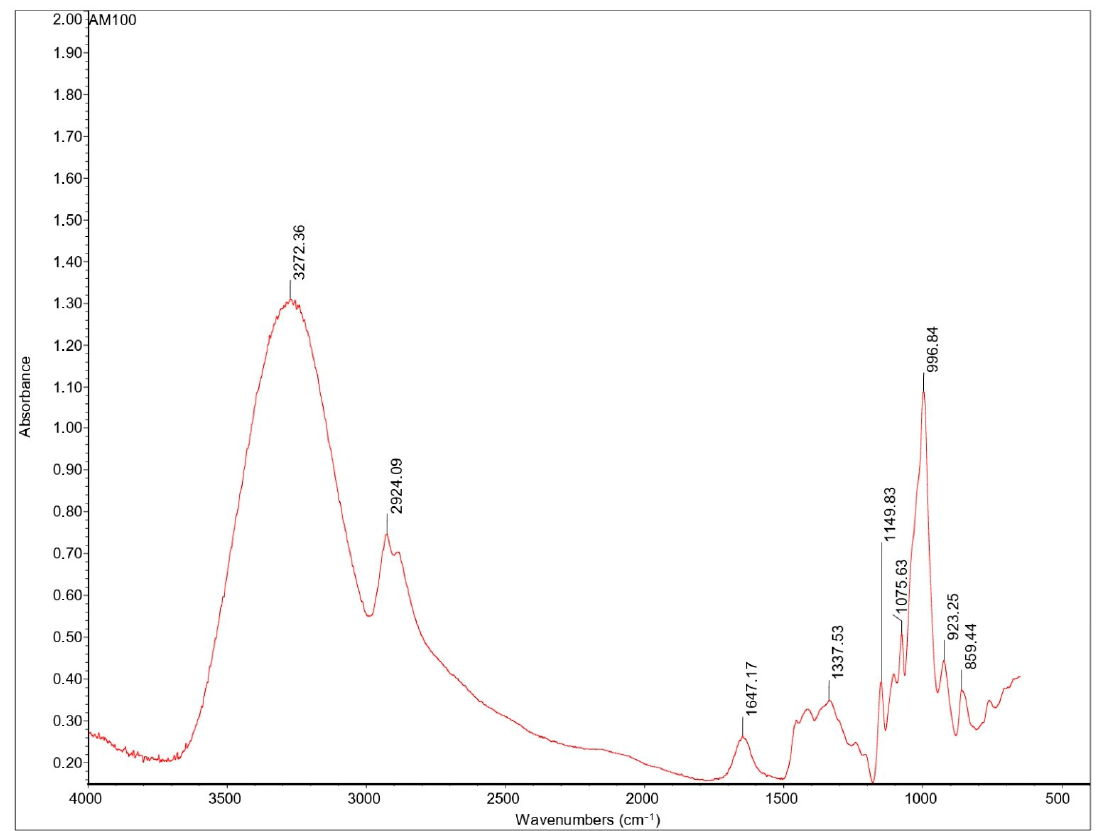
Figure 7. FT-IR spectra of AM100-based films.